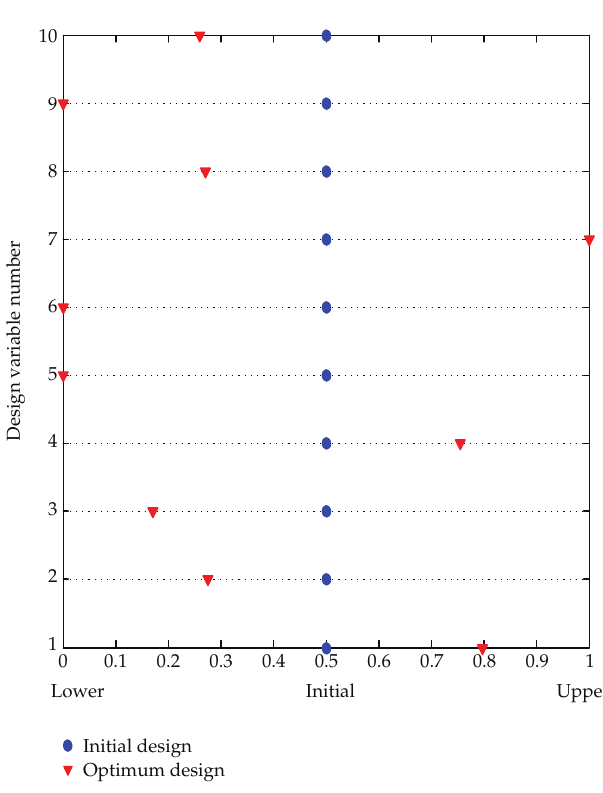
Figure 10: Changes of design variables at optimum with respect to the initial design value.